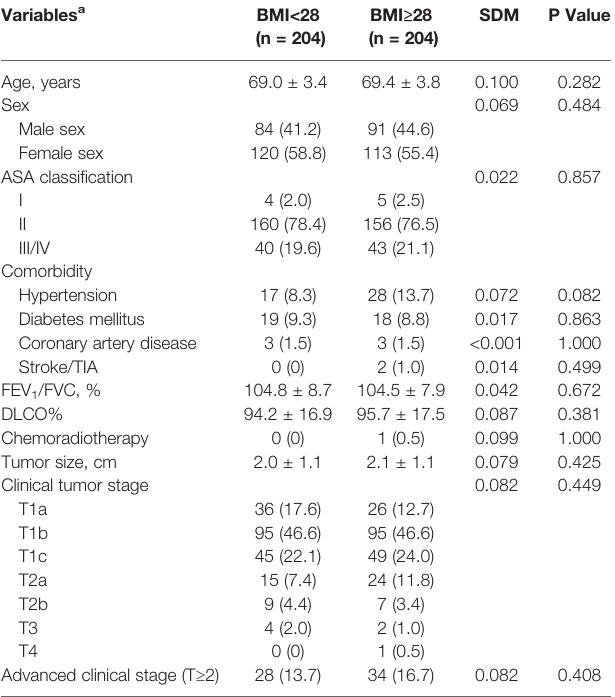
TABLE 4 | Baseline characteristics strati fi ed by BMI after a 1:1 PSM.